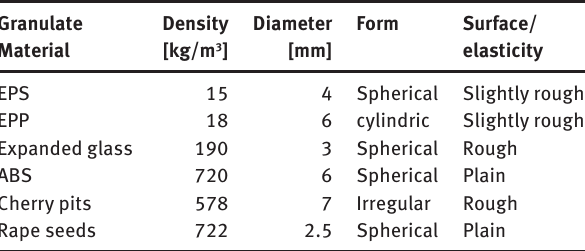
FormHand cushion can be